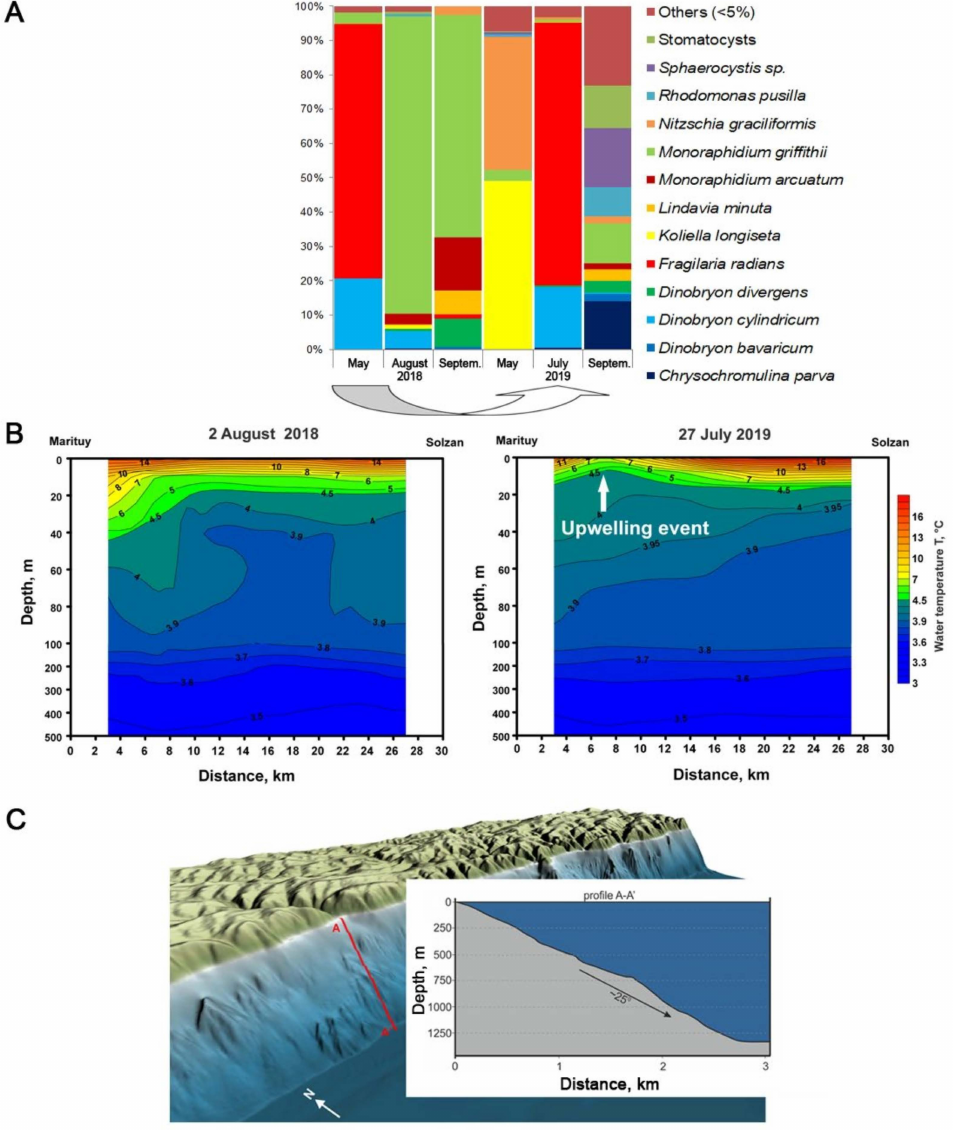
Figure 4. Was the high abundance of spring diatoms in the photic zone of Lake Baikal in July 2019 due to an upwelling event? ( A ) Species composition and relative abundance of microalgae at Stations 2 and 2* located near Marituy, where a high abundance of Fragilaria radians was observed in July 2019; ( B ) Baikal water temperature profiles at the transect of Marituy and Solzan at the moment of phytoplankton sampling in late July to early August in 2018 and 2019 (arrow—7 km from Marituy, Station 2*); ( C ) digital relief model of the South Baikal slope (red line shows the A-A (cid:48) bathymetric profile given in the